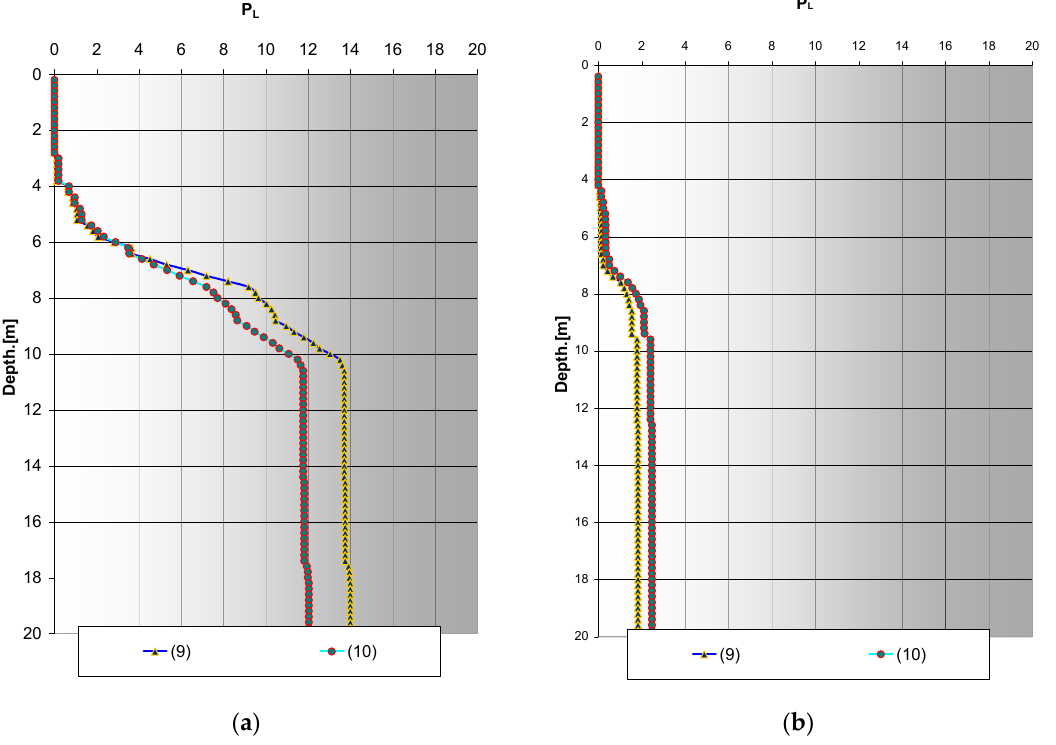
Figure 10. Evaluation of Liquefaction potential Index P L from K d data: ( a ) SDMT A; ( b ) SDMT B.